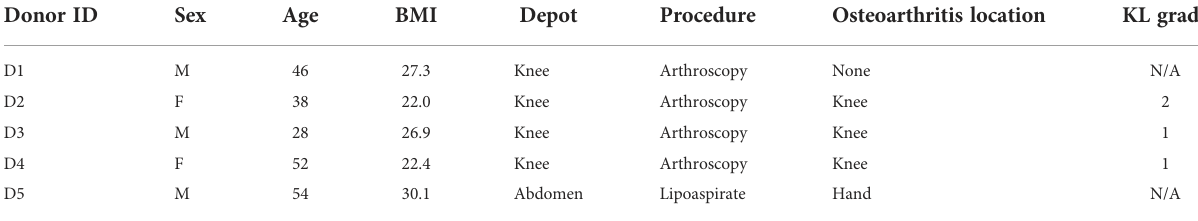
TABLE 1 Summary of MSC(AT) donor